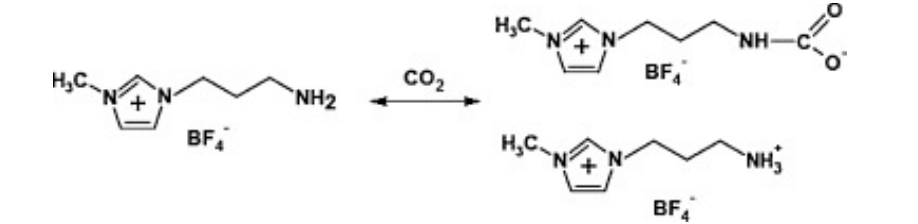
Figure 6. Mechanism of CO 2 capture by NH 2 − RTIL.